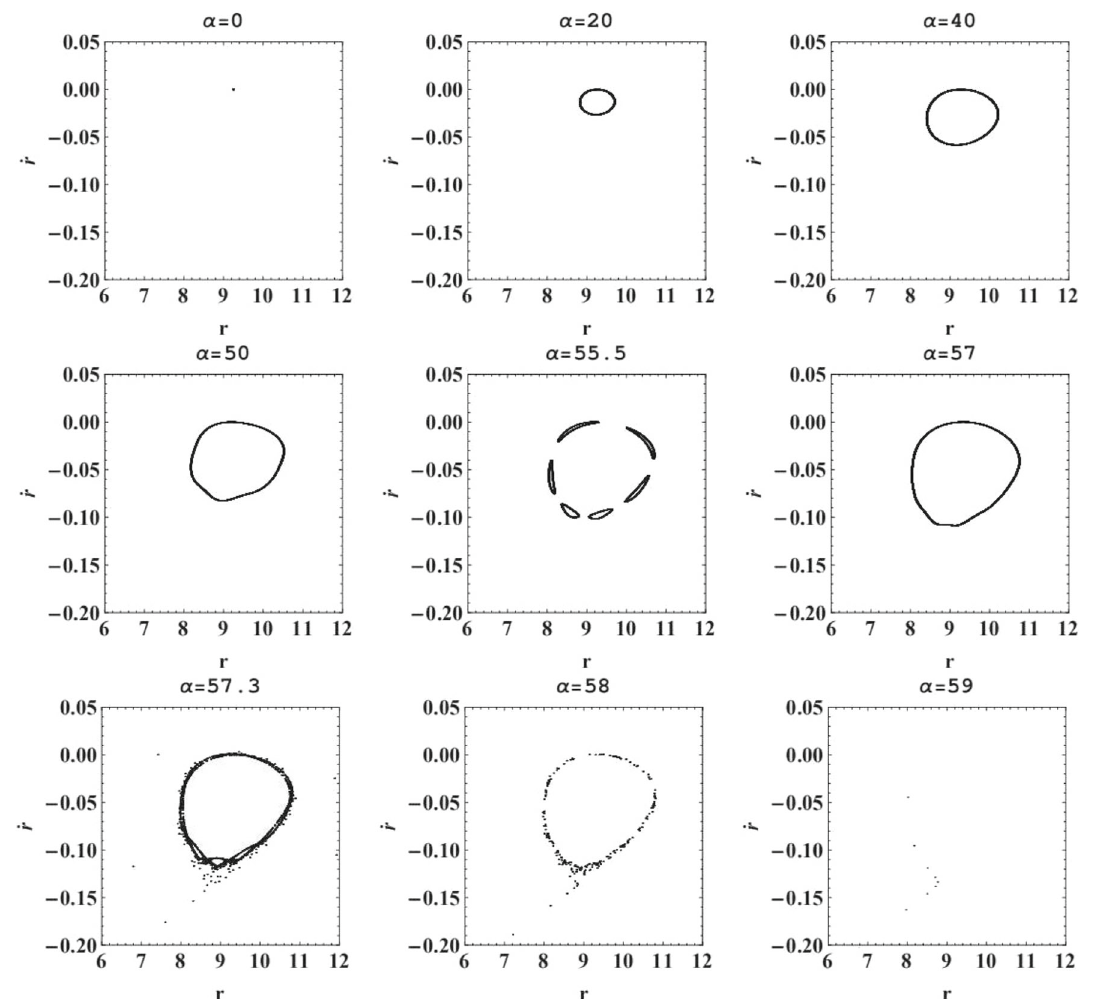
) in the plane r − ˙ r with different α for the signal plotted in Fig. 2